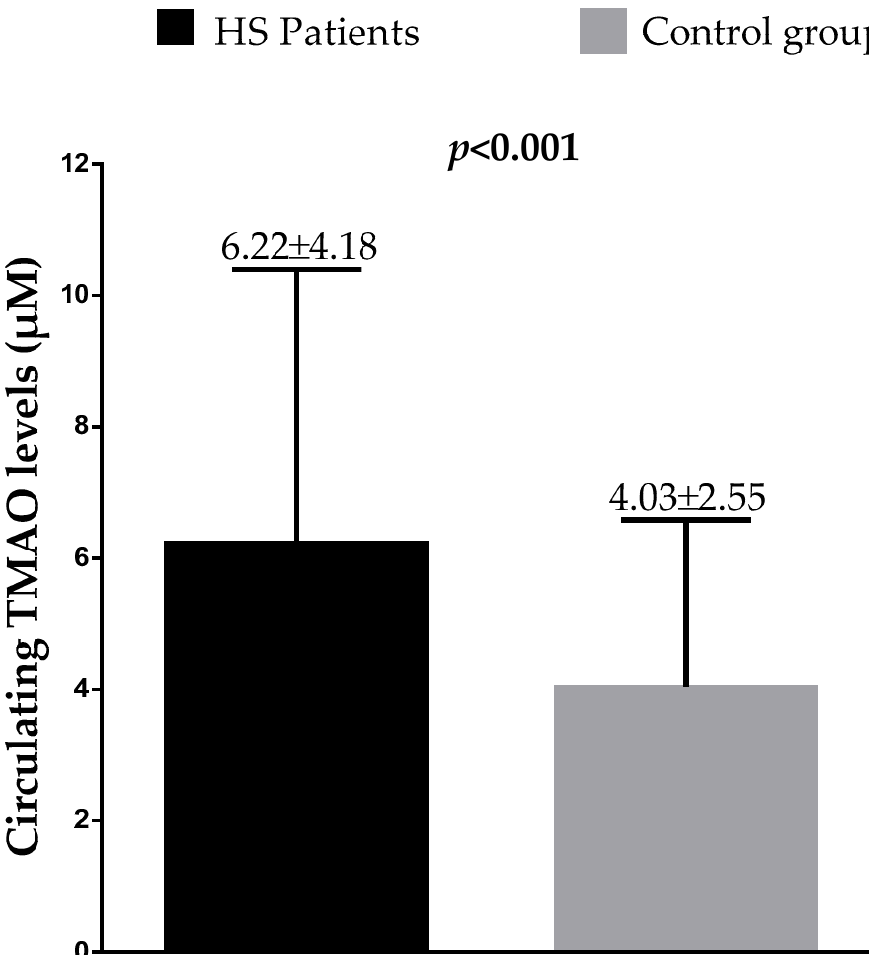
Figure 1. Difference in circulating TMAO levels between HS patients and control group. Differ- ence was analyzed by Student’s paired t -test. Results were expressed as mean ± SD. A p value in bold type denotes a significant difference ( p < 0.05). HS, hidradenitis suppurativa; TMAO, trimethylamine n-oxide.